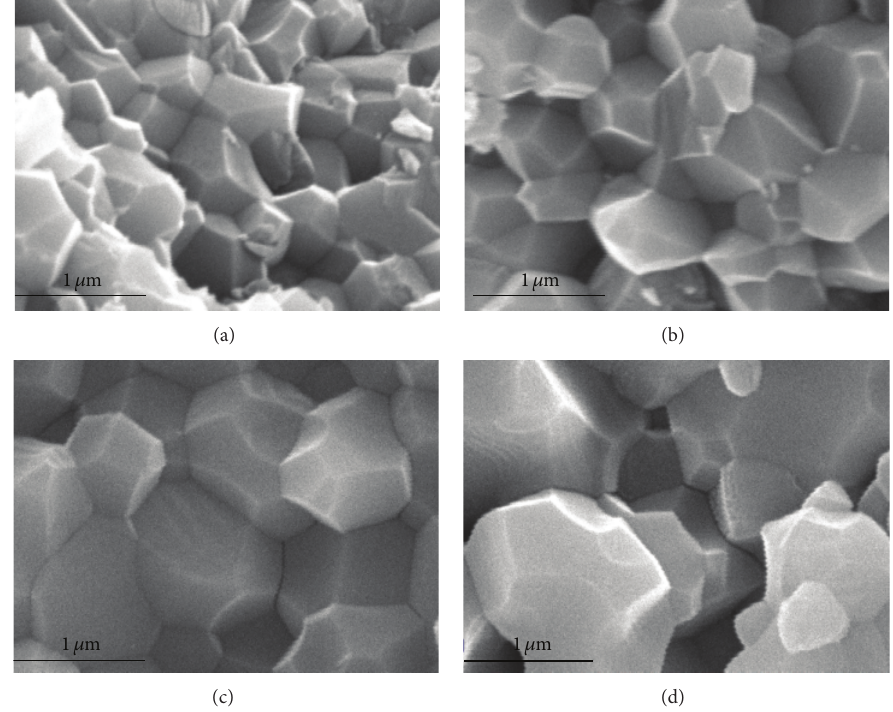
Figure 6: SEM images of the fractured surfaces of the coated samples. (a) 30–50 nm, (b) 50–100 nm, (c) 100–300 nm, and (d) 300–500